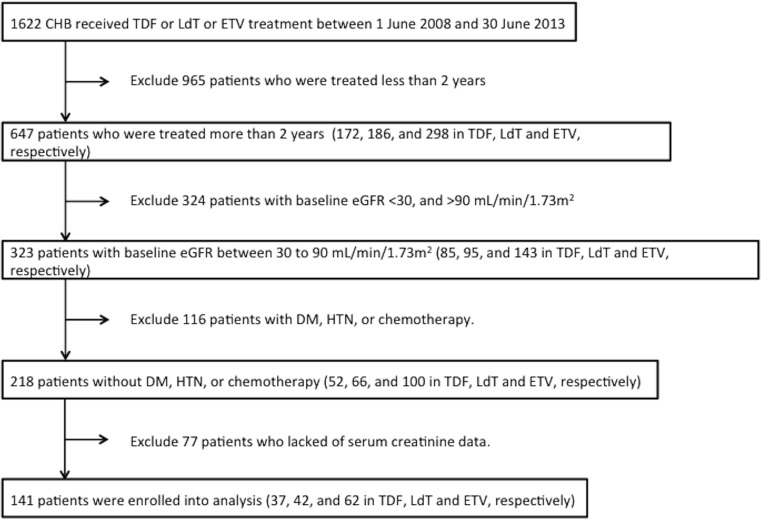
Schematic flowchart of the enrollment process.